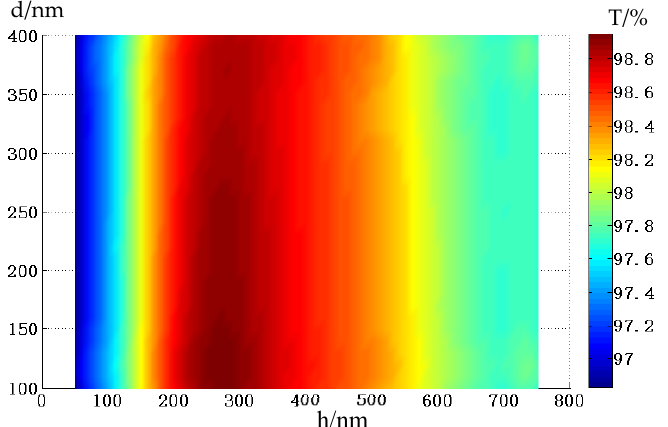
Figure 2. Reflectivity averaged over the spectral range of 800 nm~2500 nm calculated with respect to the diameter of the hole d and the depth of the hole h with Λ = 640 nm, when the structure is illuminated from the air in a normal incidence.